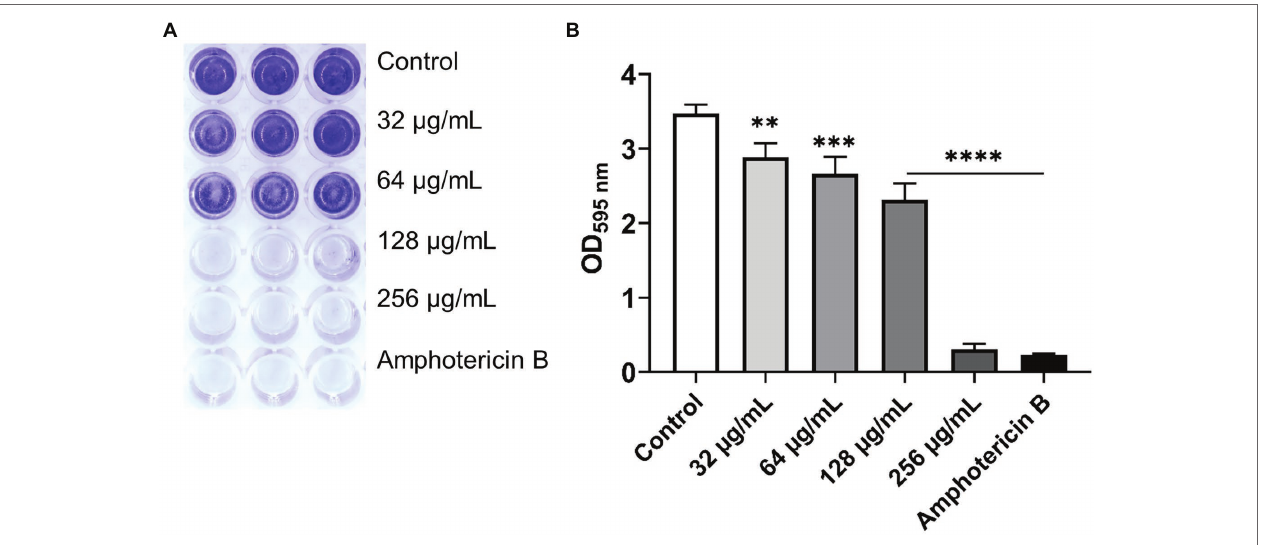
FIGURE 4 | Biofilm formation assay of Candida albicans . (A) Crystal violet staining of Candida albicans biofilm treated with various concentrations of β -citronellol and amphotericin B (2 μ g/ml) for 24 h. (B) Absorbance at 595 nm of destaining solution from all treatment conditions. Data are represented as mean ± SD. ** p ≤ 0.01, *** p ≤ 0.001, and **** p ≤ 0.0001 compared to the